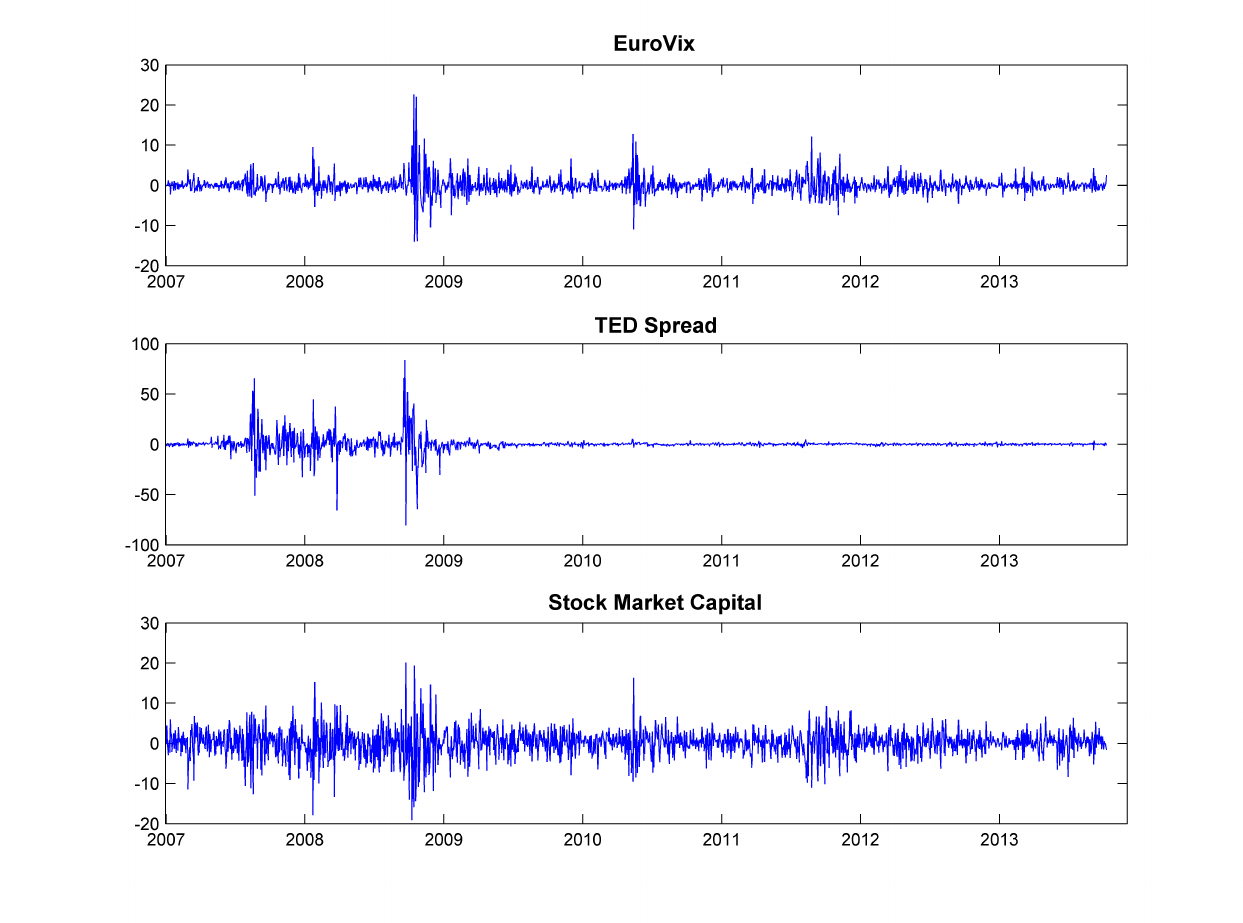
Figure 2 . Additional regressors for the empirical